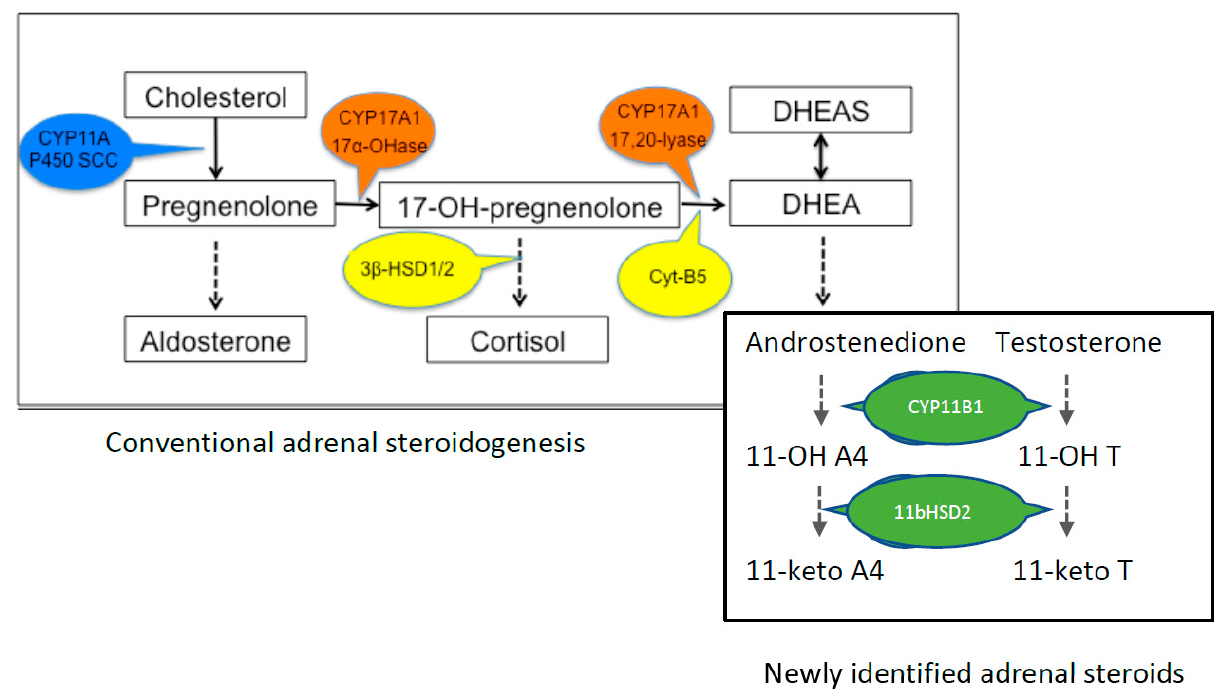
Figure 1. Key parts of the steroid pathway in relation to DHEA synthesis. For convenience, the downstream precursor components of aldosterone, cortisol and sex steroids’ synthesis are not shown. The enzymes critical for determining the availability of 17-OH-pregnenolone for DHEA synthesis are shown in the colored bubbles. The enzyme proteins are: CYP, cytochrome P450; HSD, hydroxysteroid dehydrogenase; Cyt-B5, cytochrome B5. Steroids: A4, androstenedione; T, testosterone.